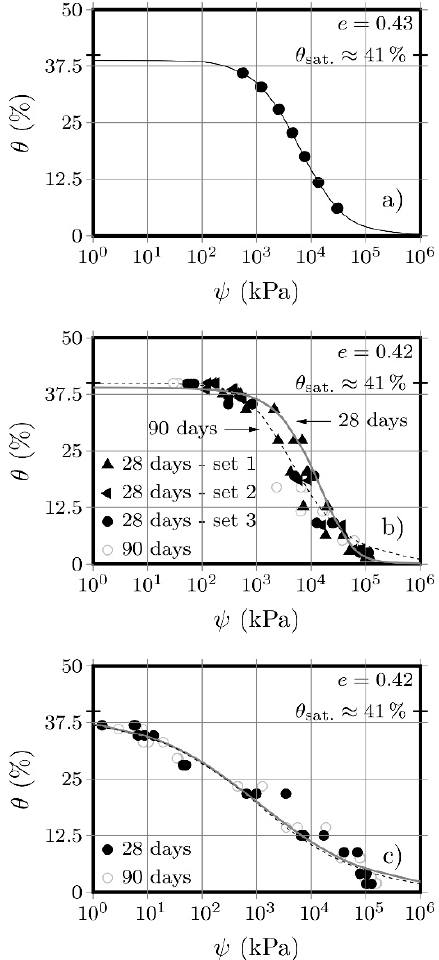
Figure 1. Experimental data and theoretical soil-water retention curves (using van Genuchten proposal) for the original soil ( a ), for the Portland cement-soil combination (OPC-S) material ( b ) and for the alkali-activated cement-soil combination (AAC-S) material ( c ) (Note 1: the values obtained with each of the 3 paper filters used are included; Note 2: three sets of tests were developed for 28-days OPC-S material; Note 3: the theoretical saturation value of the original soil was estimated at 41%, and used to fit the curves).